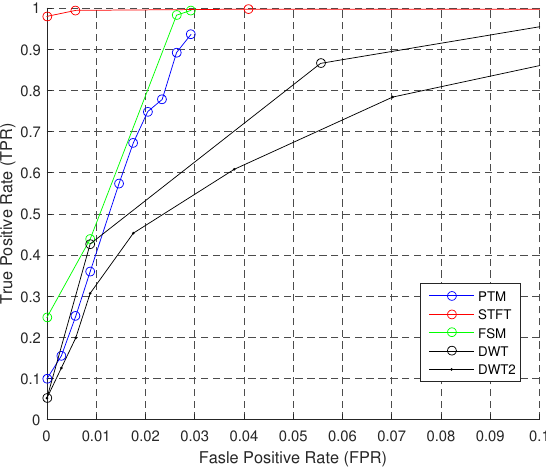
Figure 12. ROC of step counting: